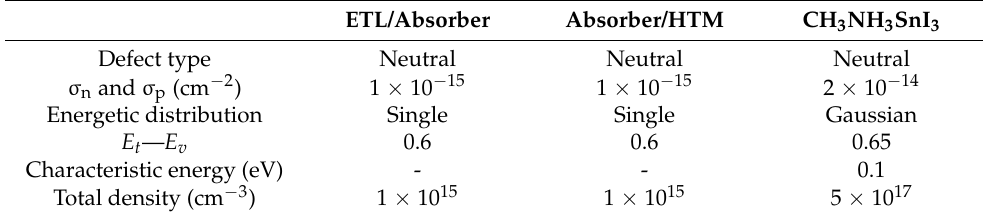
Table 2. Defect density parameters in the absorber and at the interfaces.